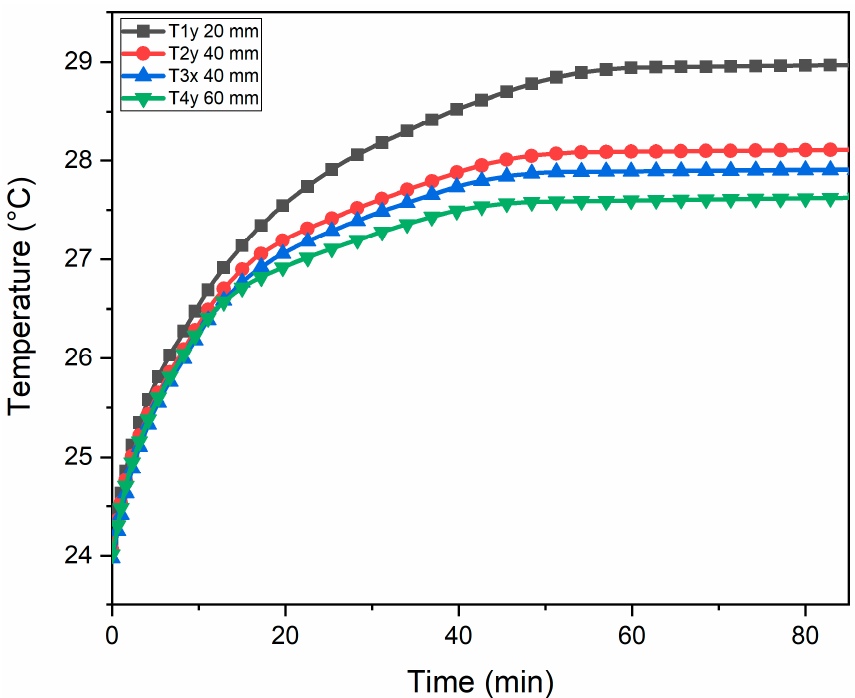
Figure 10. Temperature profile along the x - and y -axis for reverse flow configuration with power input of 10 W.